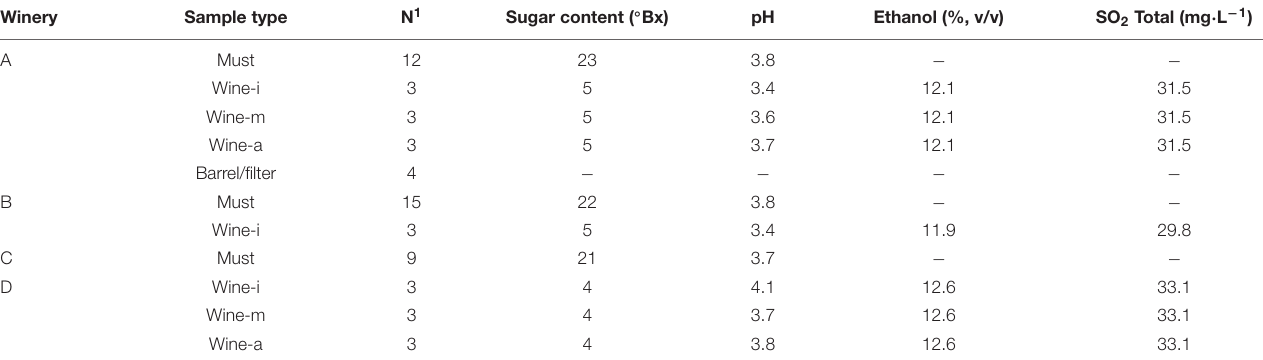
TABLE 1 | Principal characteristics of the samples collected. Winery Sample